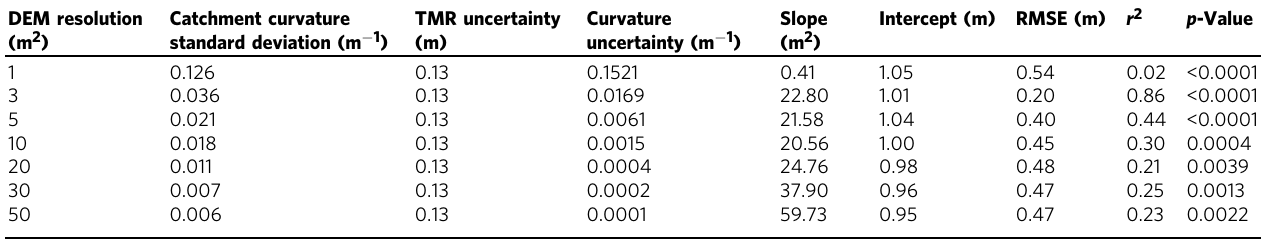
Table 2 Sensitivity of curvature-thickness of mobile regolith (TMR) relationship to resolution of digital elevation model (DEM) for the Johnston Draw data set ( N =